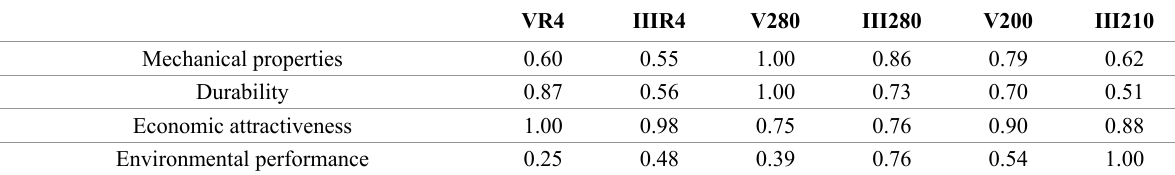
Table 9. Standardized data for 1st level analysis (Scenario 1 - Industrial